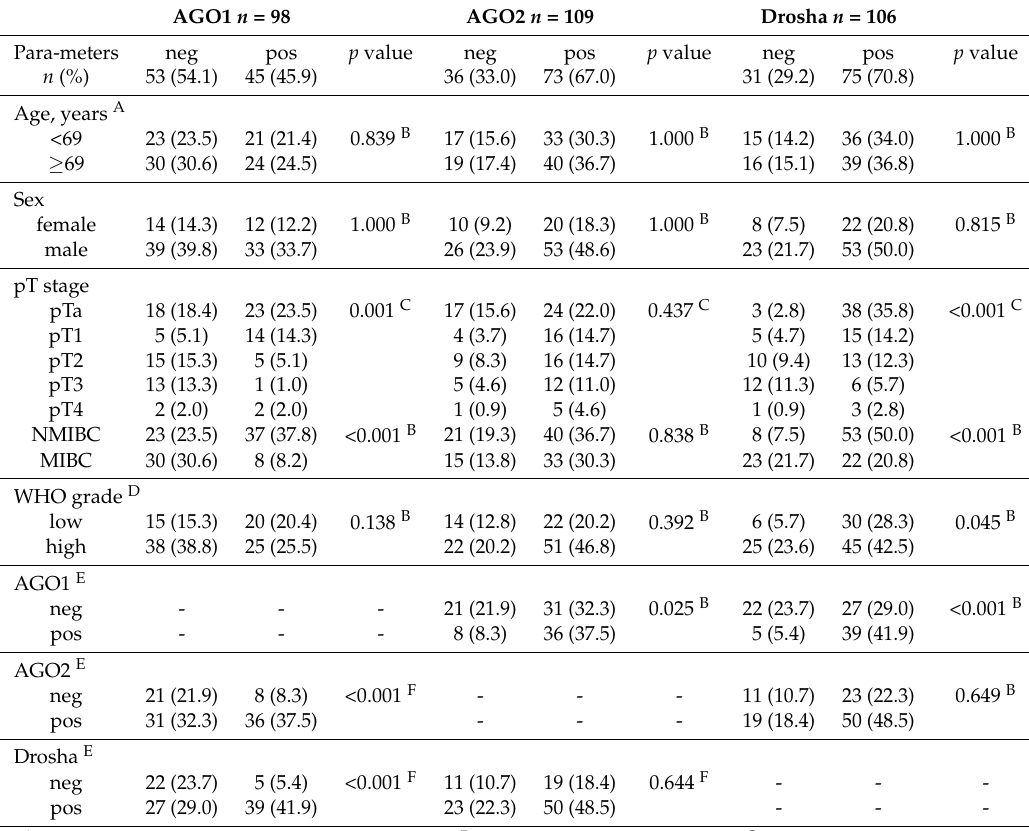
Table 3. Immunostaining of AGO1, AGO2 and Drosha associated with clinicopathological parameters of bladder cancer